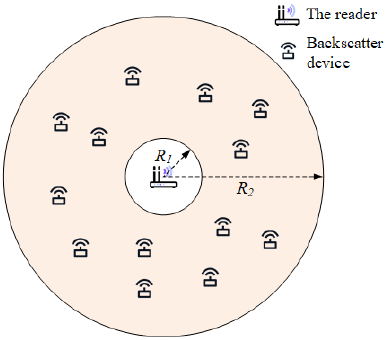
Figure 2. Spatial model in an annulus coverage of backsca tt er devices.